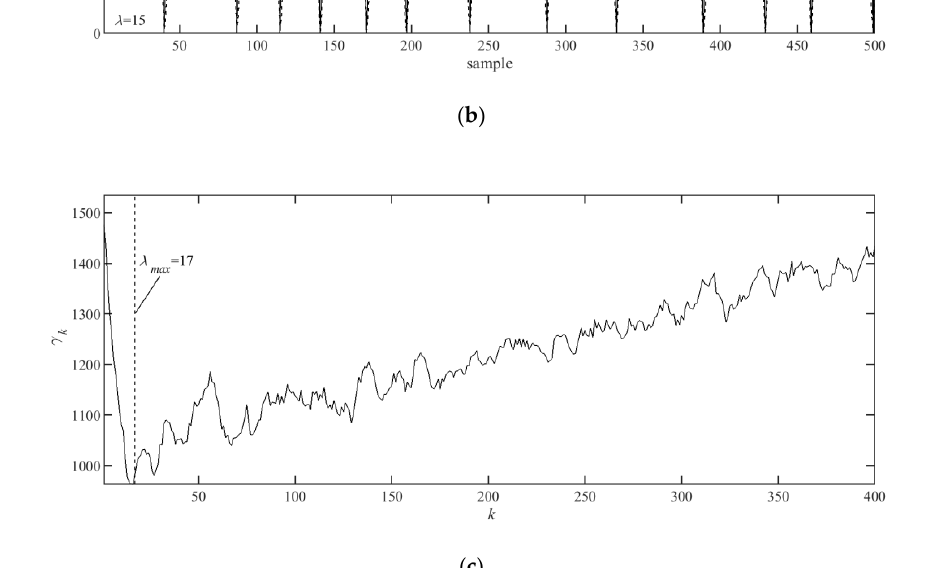
additional rule was introduced: The peak is also detected at time t ’ i .